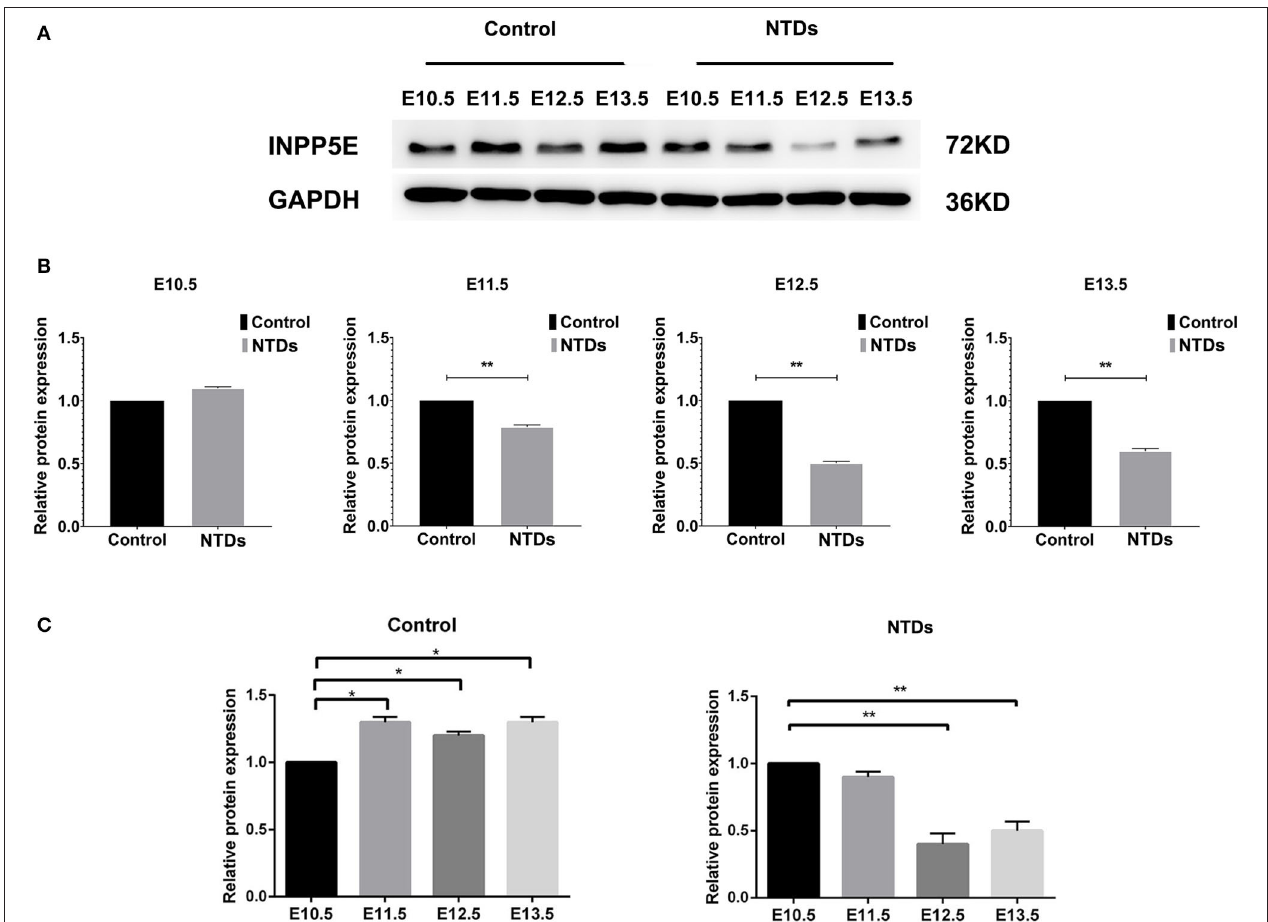
FIGURE 3 | Western blot of the protein levels of Inpp5e expression in control and NTDs embryonic brain tissues at E10.5, E 11.5, E 12.5, and E 13.5. (A, B) Inpp5e expression in embryonic brain tissues from E 10.5 to E 13.5 was determined by western blot. ** P < 0.01 NTDs group ( n = 6) vs. control group ( n = 6). (C) The dynamic changes of Inpp5e expression patterns in embryonic murine brain tissues during E 10.5–E 13.5. * P < 0.05, ** P < 0.01 vs. E 10.5. Each experiment was carried out in